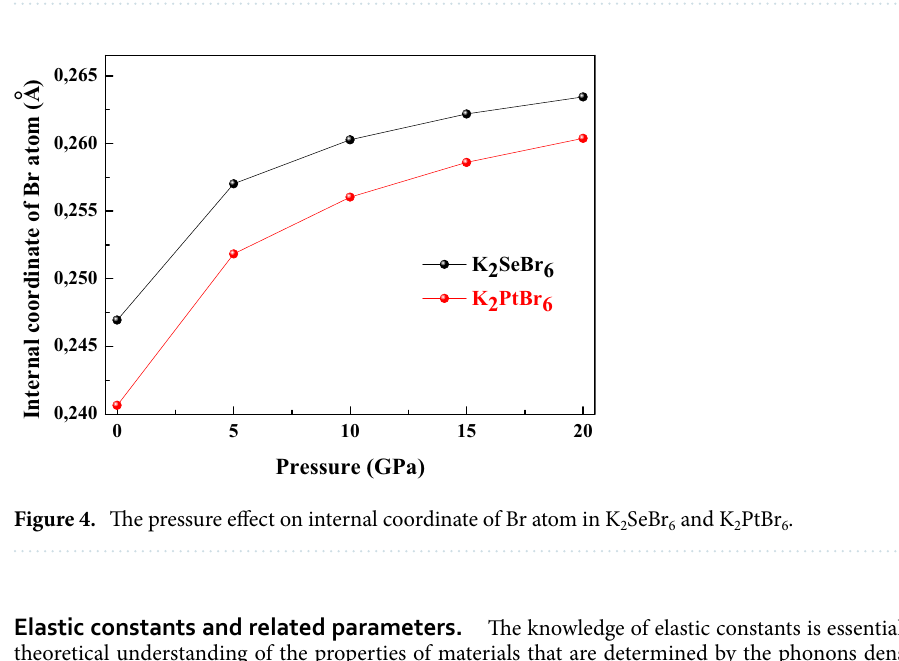
Figure 3. Effect of pressure on bond lengths d K-Br , d Br-Br and d Br-X(X=Se, Pt) in K 2 SeBr 6 and K 2 PtBr 6 .